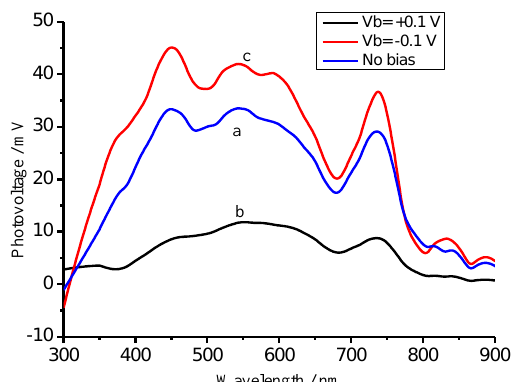
Figure 17. SPV spectra of the CuFe 2 O 4 sample biased by an external electrical field at zero ( a ), +0.1 V ( b ) and −0.1 V ( c ).